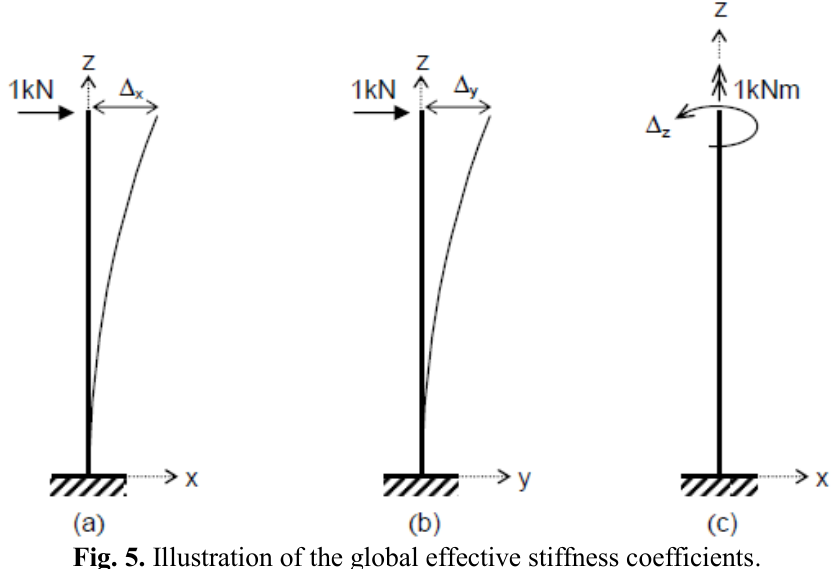
Fig. 5. Illustration of the global effective stiffness